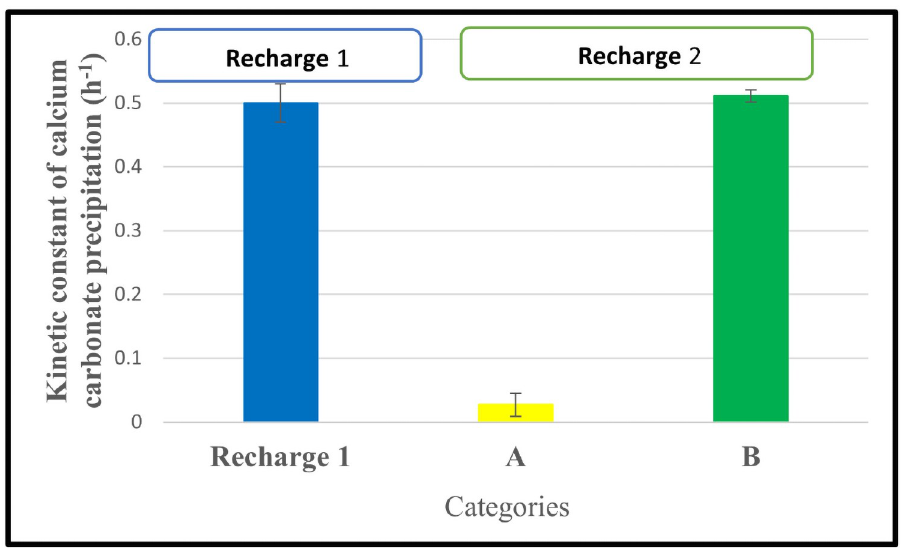
Fig 6. Comparison of kinetic constant values of first and second recharge of calcium carbonate precipitation. A– Set of three flasks used in the 2 nd recharge without the addition of bacteria. B–Set of three flasks used in the 2 nd recharge without the addition of